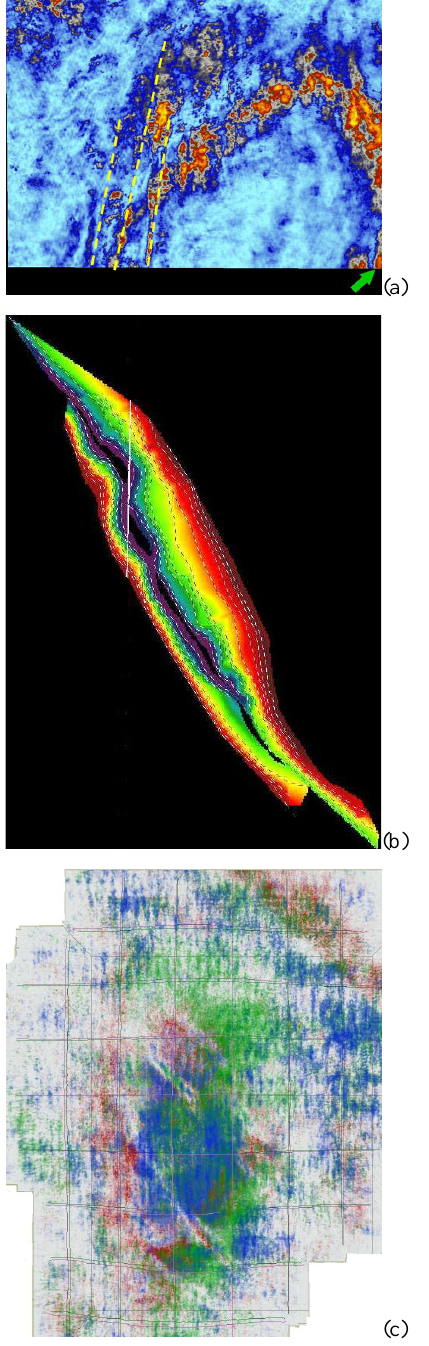
Fig. 5. (a) : CWT result at a 10Hz frequency timeslice. Yellow dashed lines display the abilities of the CWT method in fault system detection on data of the Persian Gulf, (b) : a map that resulted from fault interpretation (graben) similar to our results in this investiga- tion, and (c) : combination displayed from three iso-frequencies by using the RGB multi-displaying technique as red, green and blue colors are equal with low (10Hz), medium (15Hz) and high fre- quency (20Hz), respectively (Saadatinejad and Sarkarinejad, 2011).